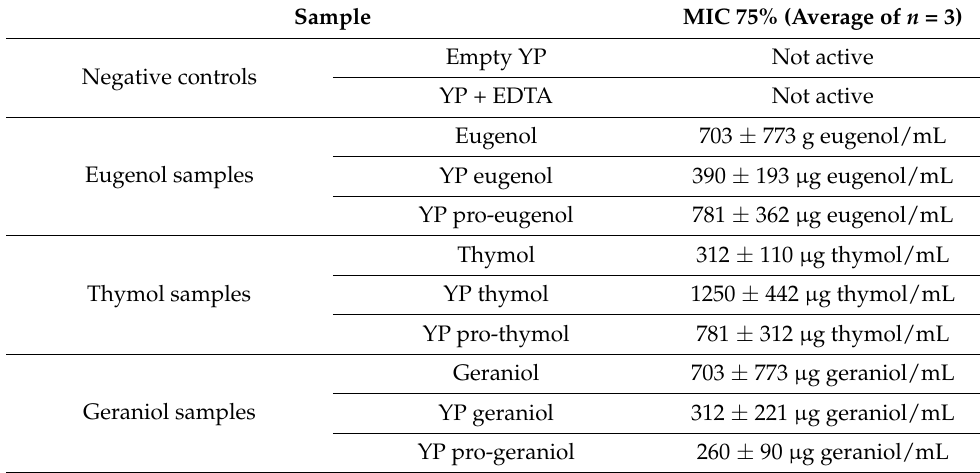
Table 4. In vitro antifungal activity on Saccharomyces cerevisae of free terpene, YP terpene and YP pro-terpene